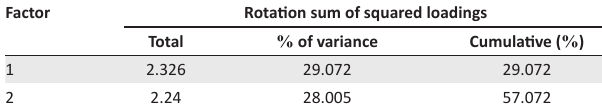
TABLE 2: Factor loadings after rotation.